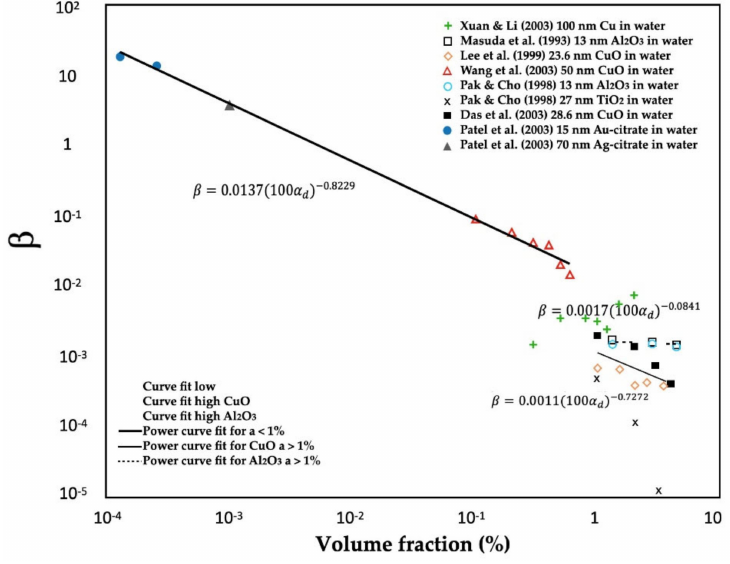
Figure 4. Determination of the function β derived from experimental data, adapted from